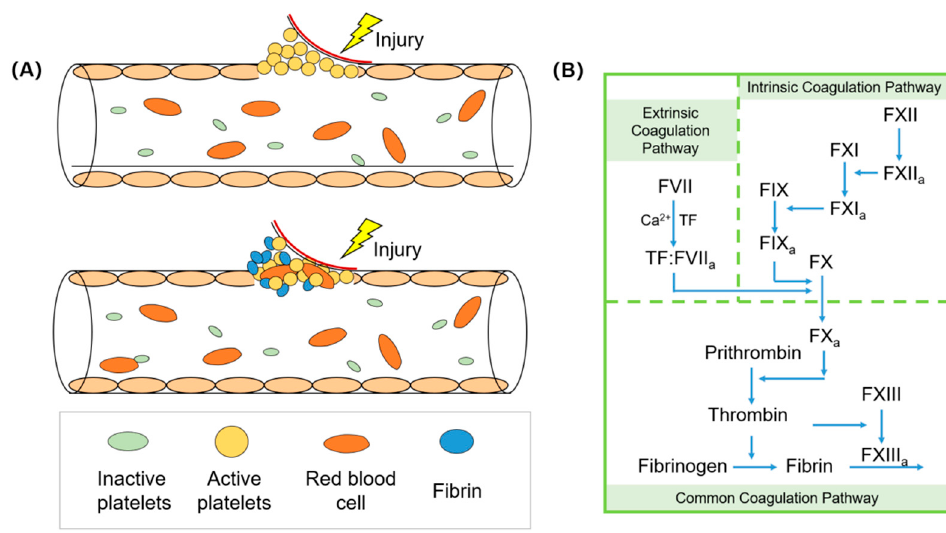
Figure 1. Mechanism diagram of coagulation process. ( A ) Hemostatic simulation diagram of dam- aged vascular model; ( B ) an overview of the coagulation cascade.